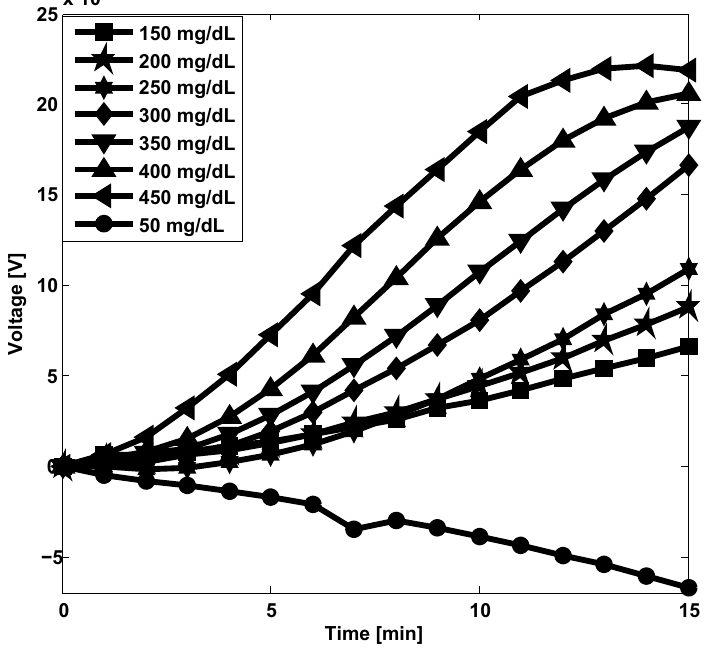
Figure 7. The output voltage as a function of time, for different glucose concentrations in the test